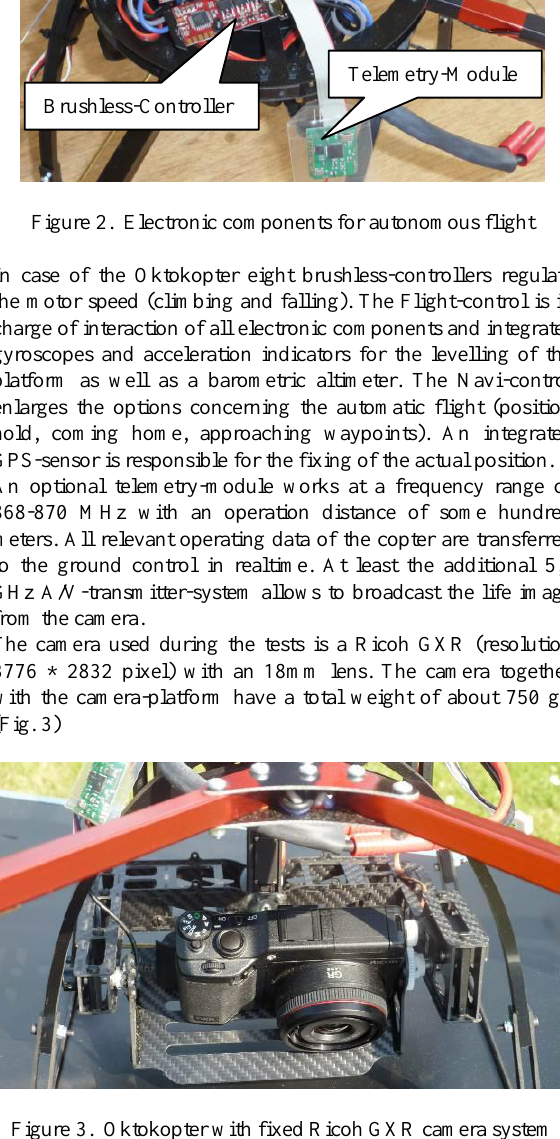
Figure 3. Oktokopter with fixed Ricoh GXR camera